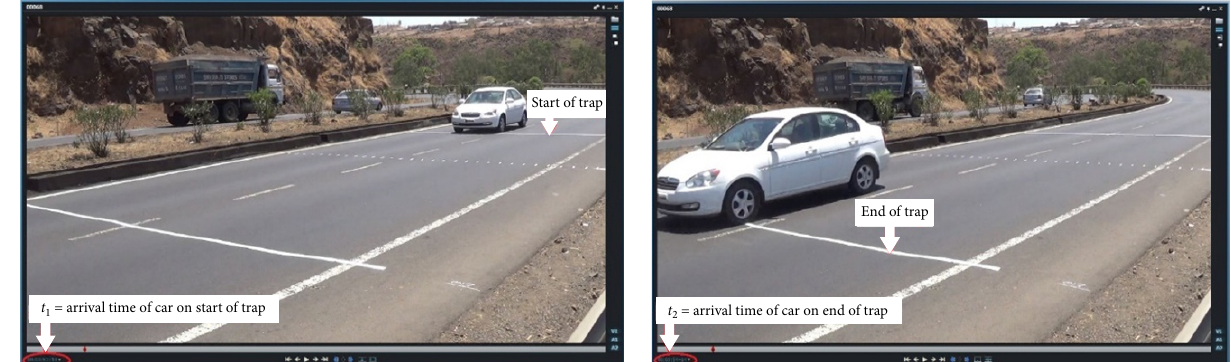
Figure 3. Passenger car tire touching the first and second line of trap